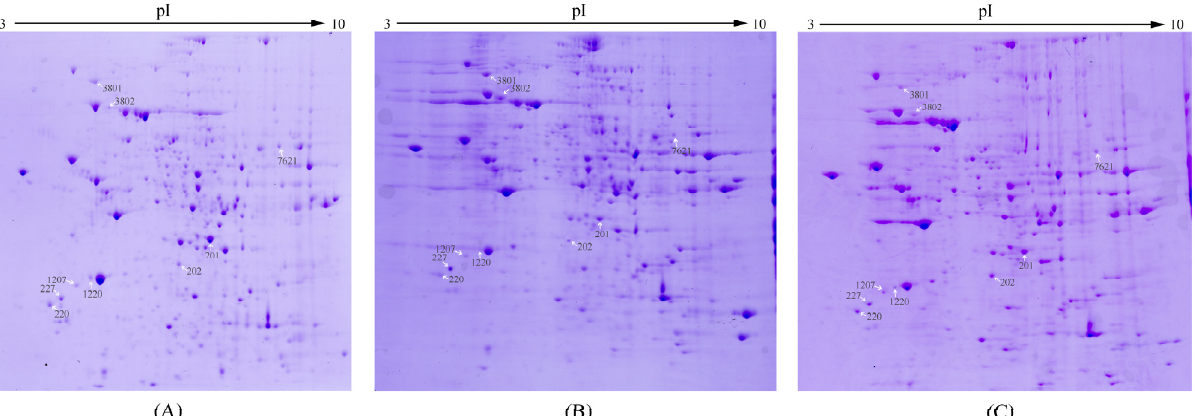
Figure 2. 2-DE gel images from normal group ( A ); model group ( B ); and 5'-AMP-treated group ( C ). The gel images were the representative gel of nine replicate gels collected from three independent experiments. The white arrows showed the differentially expressed spots chosen for MALDI-TOF MS/MS